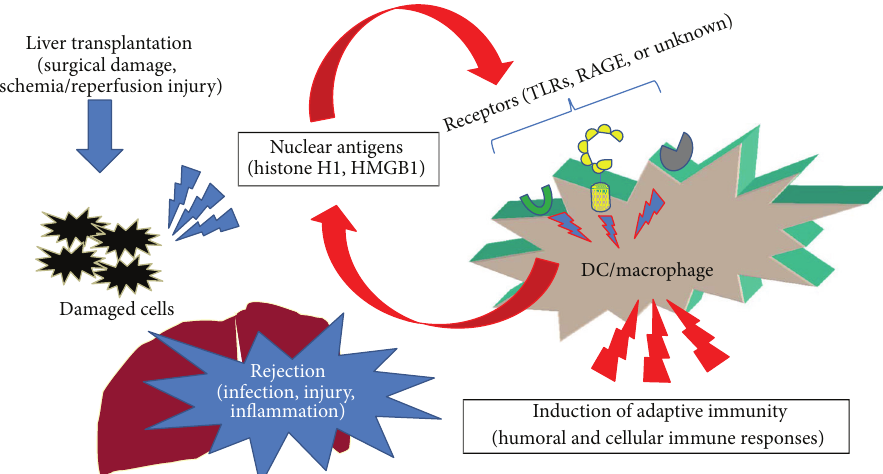
Figure 1: Histone H1 and HMGB1 as “nuclear weapons” in innate and adaptive immune responses. Nuclear antigens released from damaged cells or actively secreted from activated immune cells such as DCs and macrophages are important initiators for the activation of humoral and cellular immune responses during peritransplant ischemia/reperfusion injury and posttransplant rejection as well as infection, injury, and